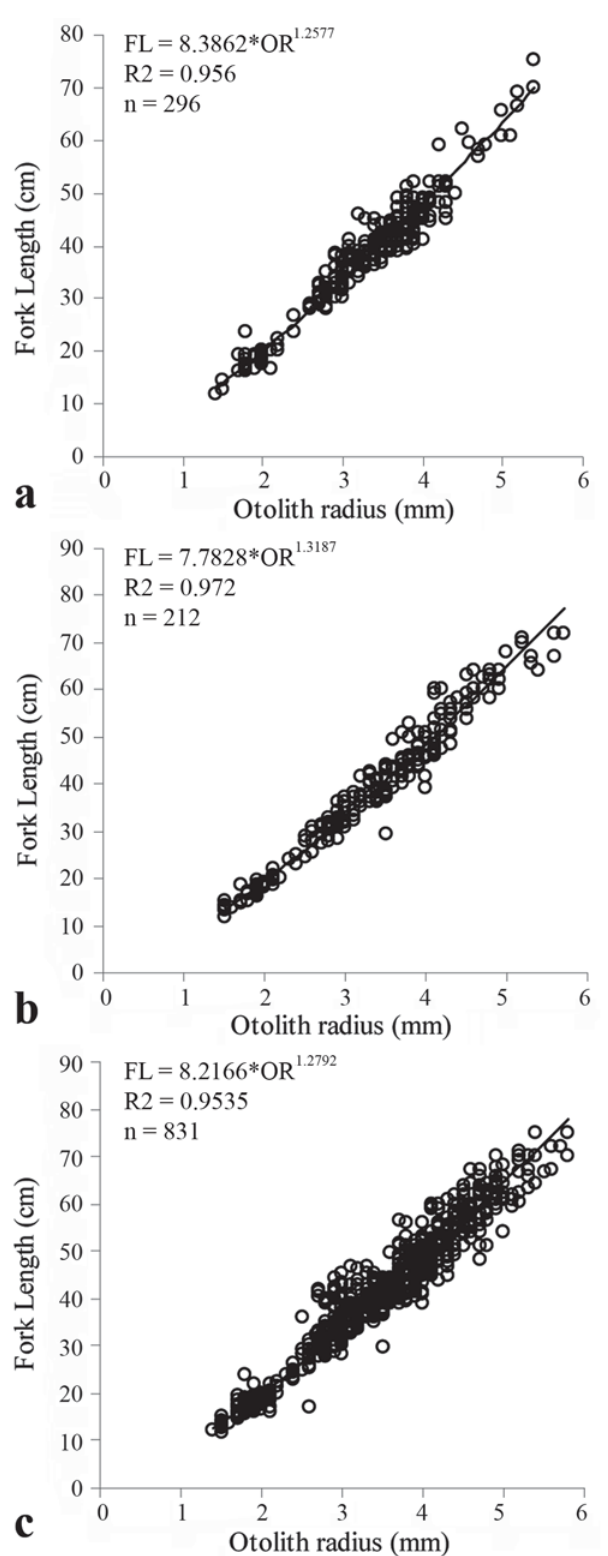
Fig. 5. Relationship between OR and FL for males (a), females (b) and combined sexes (c), showing adjusted potential model for Scomberomorus brasiliensis collected off northeastern Brazil.